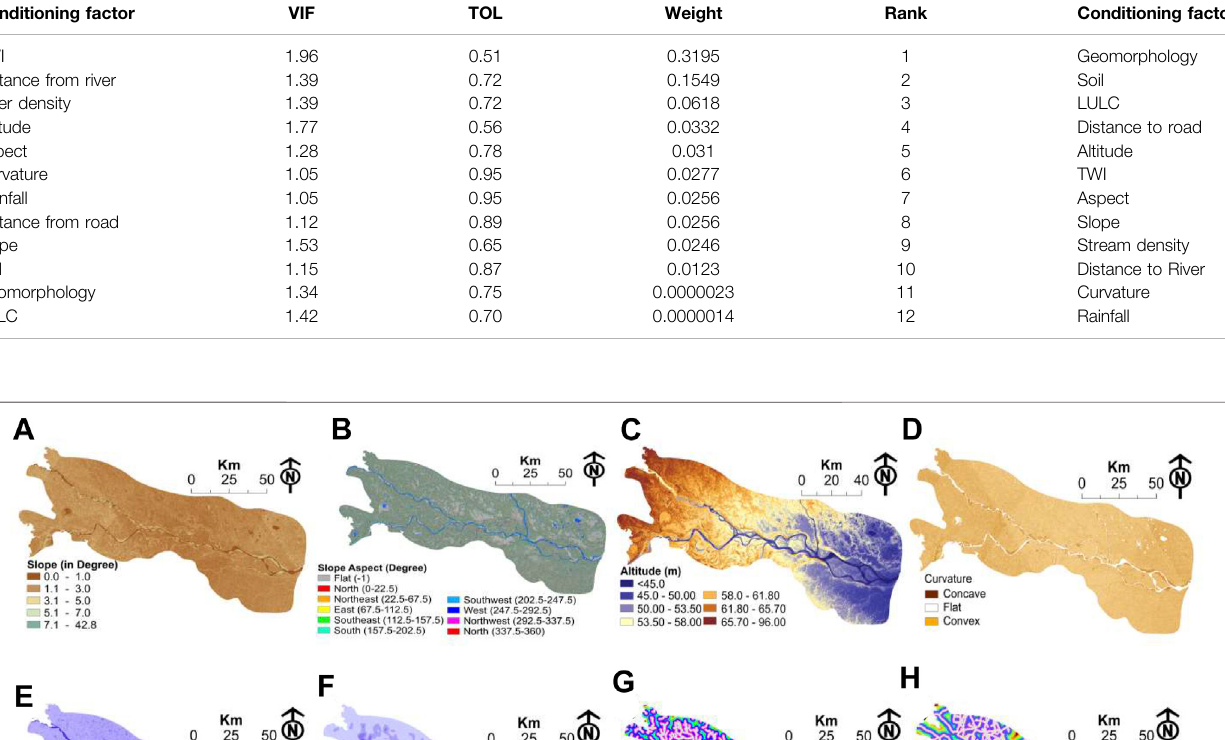
TABLE 2 | Multicollinearity test results of all the conditioning factors; information gain (IG) attribute evaluation method for selection of fl ood conditioning factors using 300 fl ood and 300 non- fl ood points in Weka Software. Multicollinearity analysis